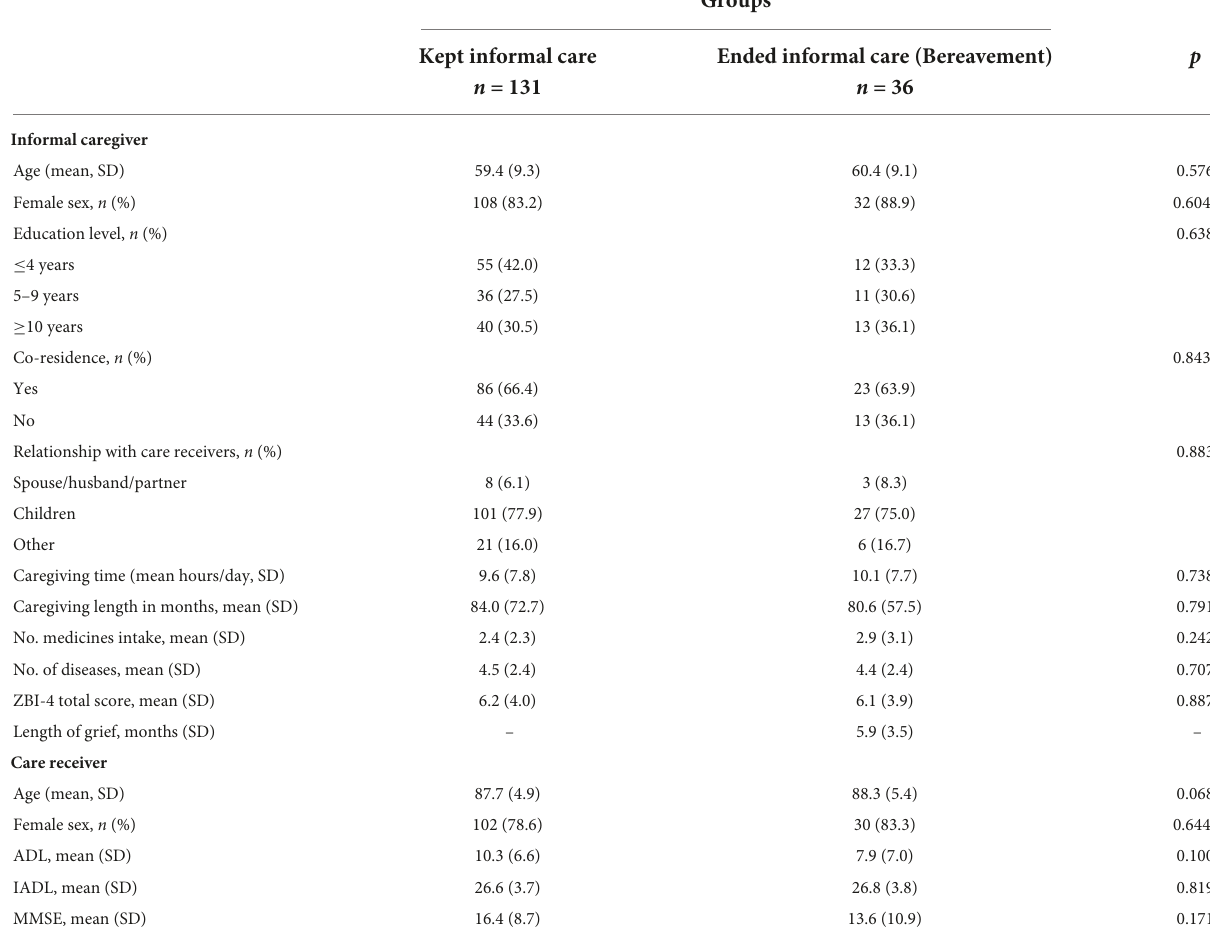
TABLE 1 Descriptive analysis for sociodemographic, context, and health characteristics’ of participants and differences between groups, at baseline.